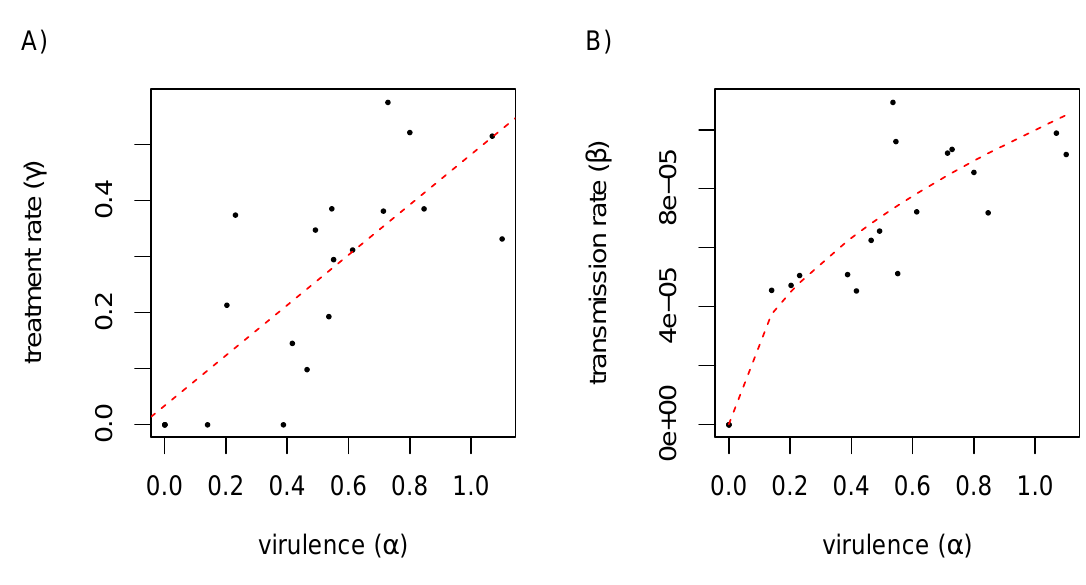
Figure S3 – Trade-off relationships between model parameters. A) Positive covariance between virulence and treatment rate (values are drawn from a multivariate distribution). B) Trade-off relationship assumed between transmission rate and virulence and points obtained when by adding noise to the transmission rates (normal distribution with mean β α p 0 i and variance 0.2). Dashed lines show the results of a linear model fit between and γ in panel A, and the theoretical trade-off relationship from equation 5 for panel